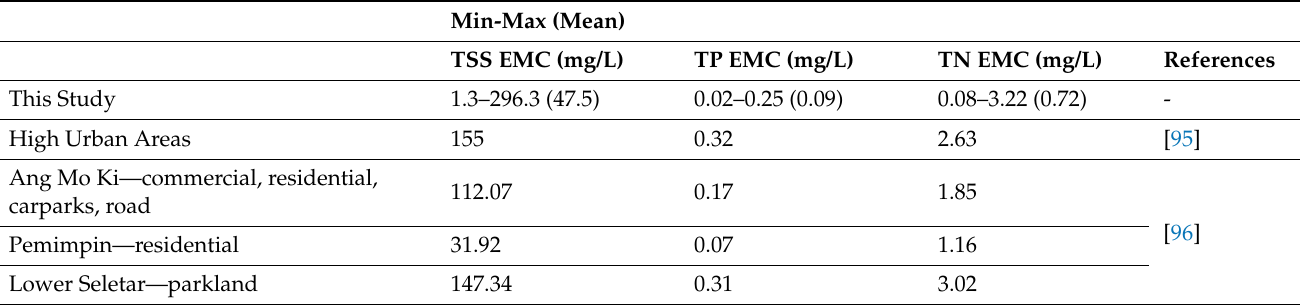
Table A9. Runoff water quality of the study area and comparison with literature